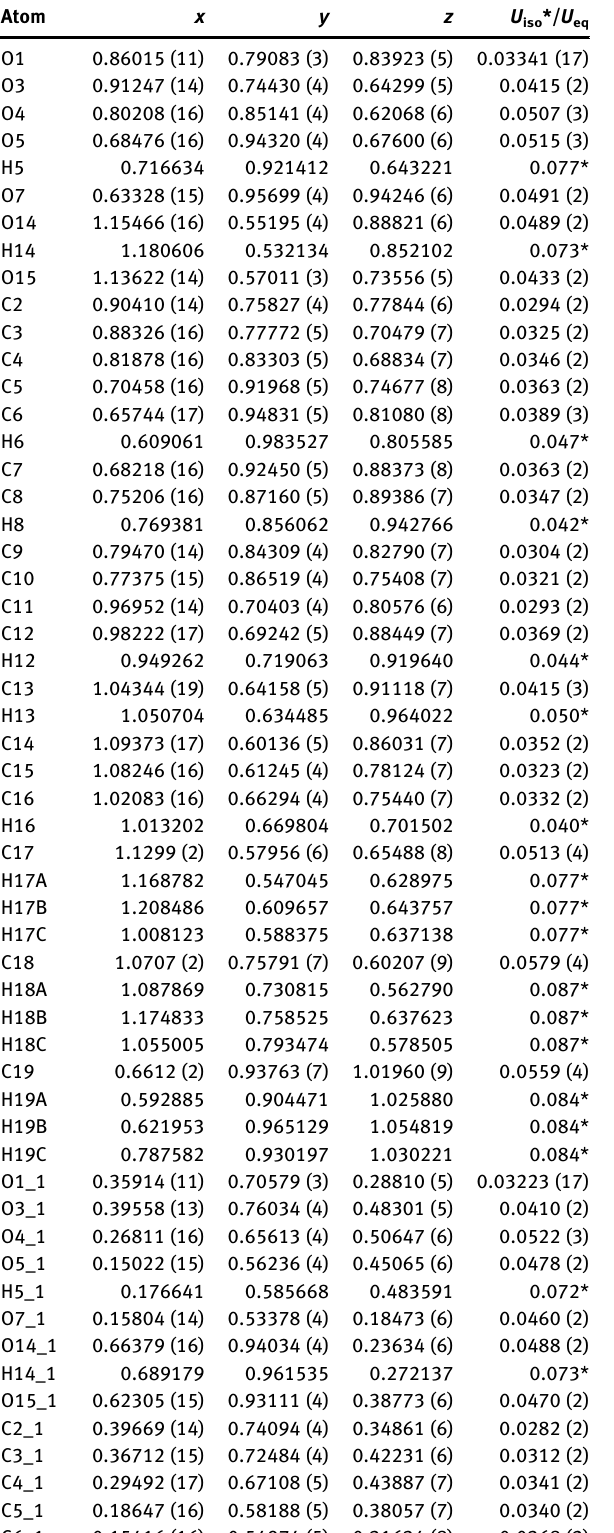
Table  : Fractional atomic coordinates and isotropic or equivalent isotropic displacement parameters (Å  ).